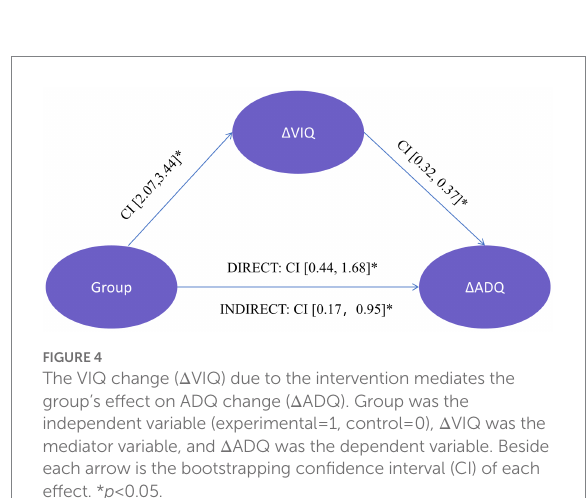
FIGURE 4 The VIQ change ( Δ VIQ) due to the intervention mediates the group’s effect on ADQ change ( Δ ADQ). Group was the independent variable (experimental = 1, control = 0), Δ VIQ was the mediator variable, and Δ ADQ was the dependent variable. Beside each arrow is the bootstrapping confidence interval (CI) of each effect. * p <